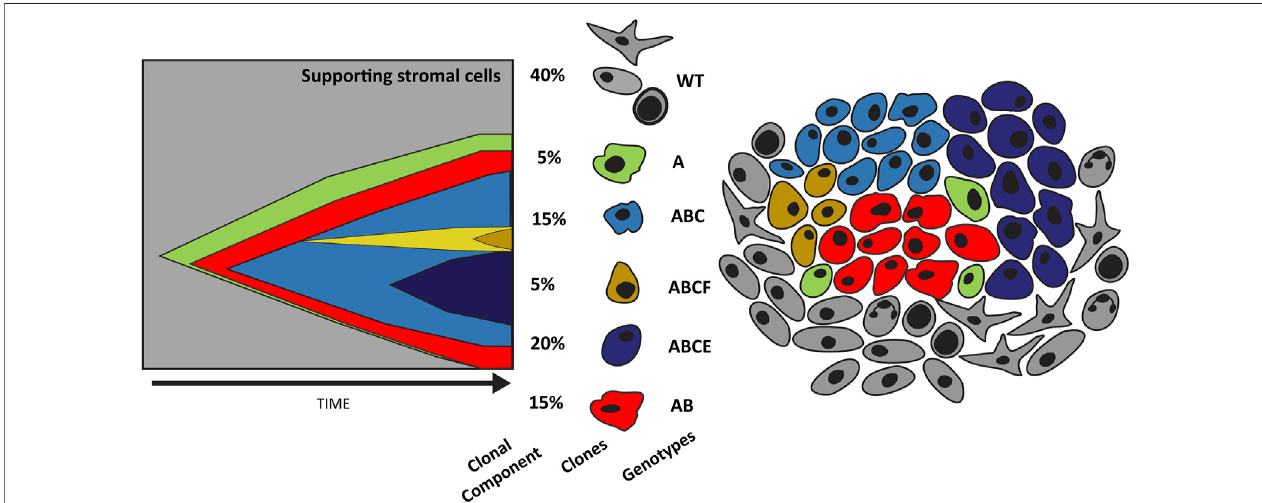
FIGURE 2 | Evolution of tumor heterogeneity. The graph on the left depicts the evolution of cancer cells as described by the original cancer stem cell theory. Here cancer stem cells (green) can replicate and differentiate into individual clones (red) that over time accumulate mutations secondary to selective pressures (blue and yellow). This results in signi fi cant tumor heterogeneity as depicted in the illustration on the right. Tumor heterogeneity increases treatment challenges and nominates a conserved population such as cancer stem cells as a potential therapeutic target.